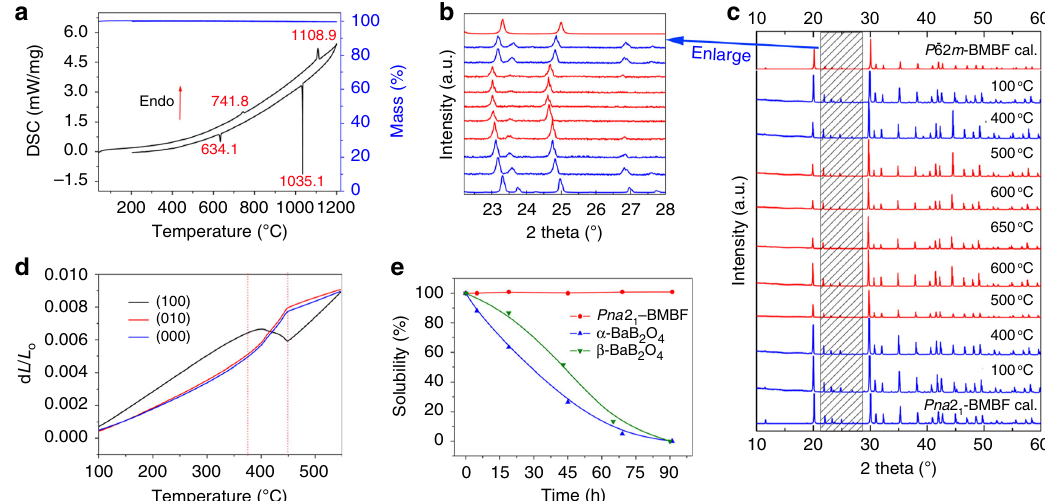
Fig. 1 Basic physicochemical properties of Ba 3 Mg 3 (BO 3 ) 3 F 3 . a Thermal gravimetric and differential scanning calorimetry (DSC) curves. Endo means the endothermic direction. There are two remarkable endothermic peaks (741.8 and 1108.9 °C) on the heating curve and two exothermic peaks (634.1 and 1035.1 °C) on the cooling curve, respectively. b , c High-temperature in situ powder X-ray diffraction data circularly collected in the region of 100 – 650 °C. The experimental and caculated powder X-ray diffraction patterns of Pna 2 1 -Ba 3 Mg 3 (BO 3 ) 3 F 3 (blue lines) and P (cid:1) 62 m -Ba 3 Mg 3 (BO 3 ) 3 F 3 (red lines). The enlarged version of c in the 2 θ region from 22.3 to 28.2° is shown in b to better understand the phase transition behavior between two polymorphs. d Thermal expansion measurements tested by (100), (010), and (001) Pna 2 1 -Ba 3 Mg 3 (BO 3 ) 3 F 3 crystal plates. d L and L 0 mean the change in crystal plates length and initial length of crystal plates, respectively. e Solubility experiments of Pna 2 1 -Ba 3 Mg 3 (BO 3 ) 3 F 3 , α - and β -BaB 2 O 4